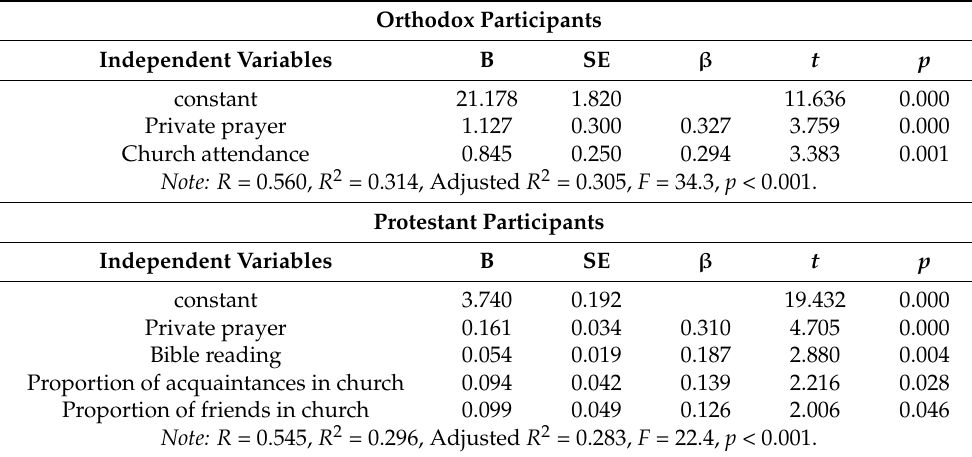
Table 10. Stepwise regression analysis on prediction of positive religious